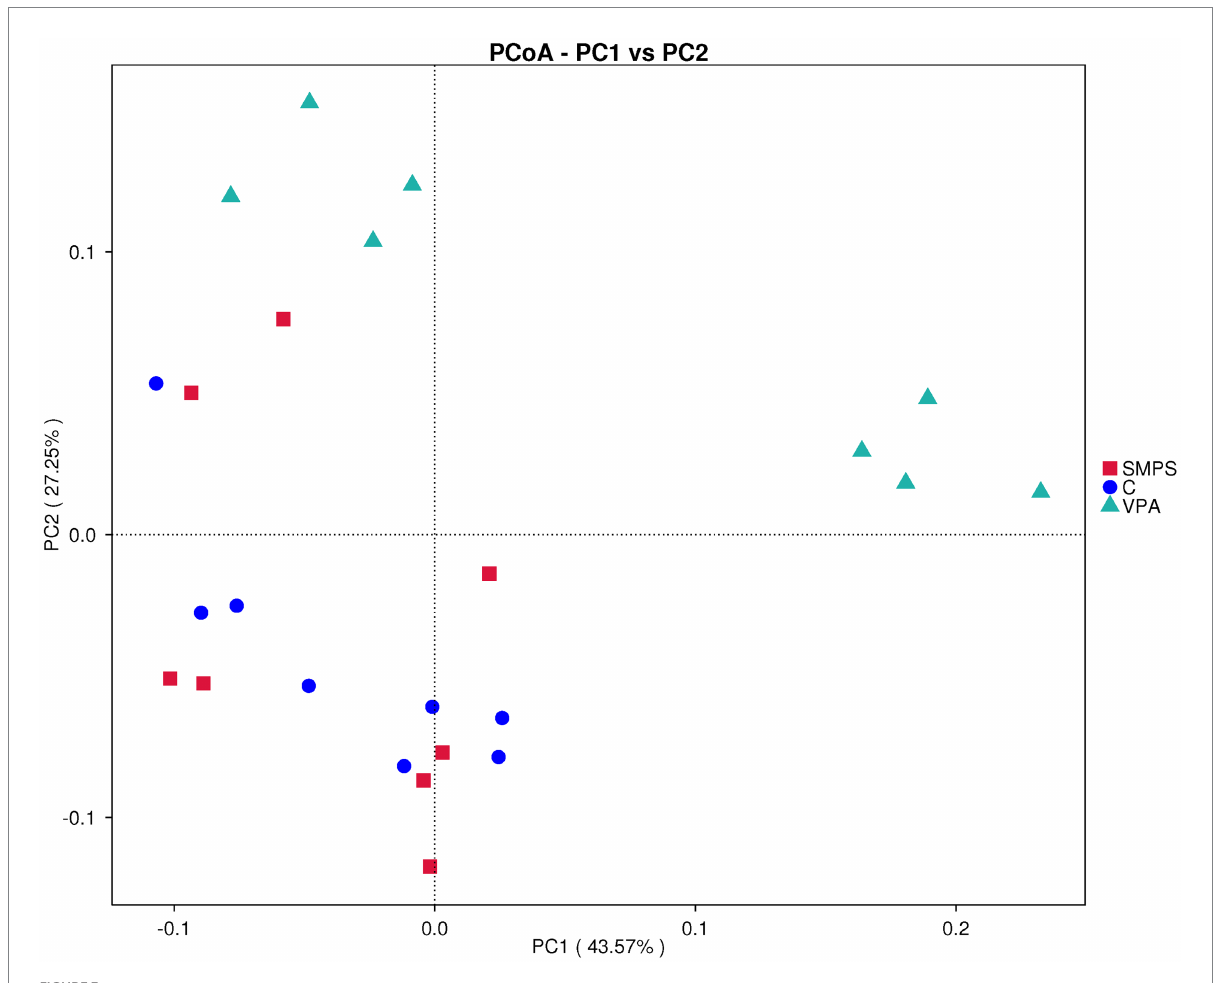
FIGURE 3 Beta diversity analysis for PCoA chart ( n = 8, per